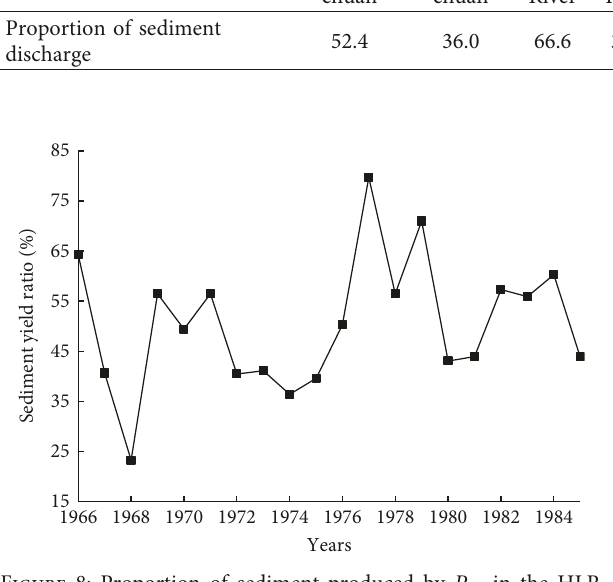
Figure 8: Proportion of sediment produced by P from 1966 to 1985.